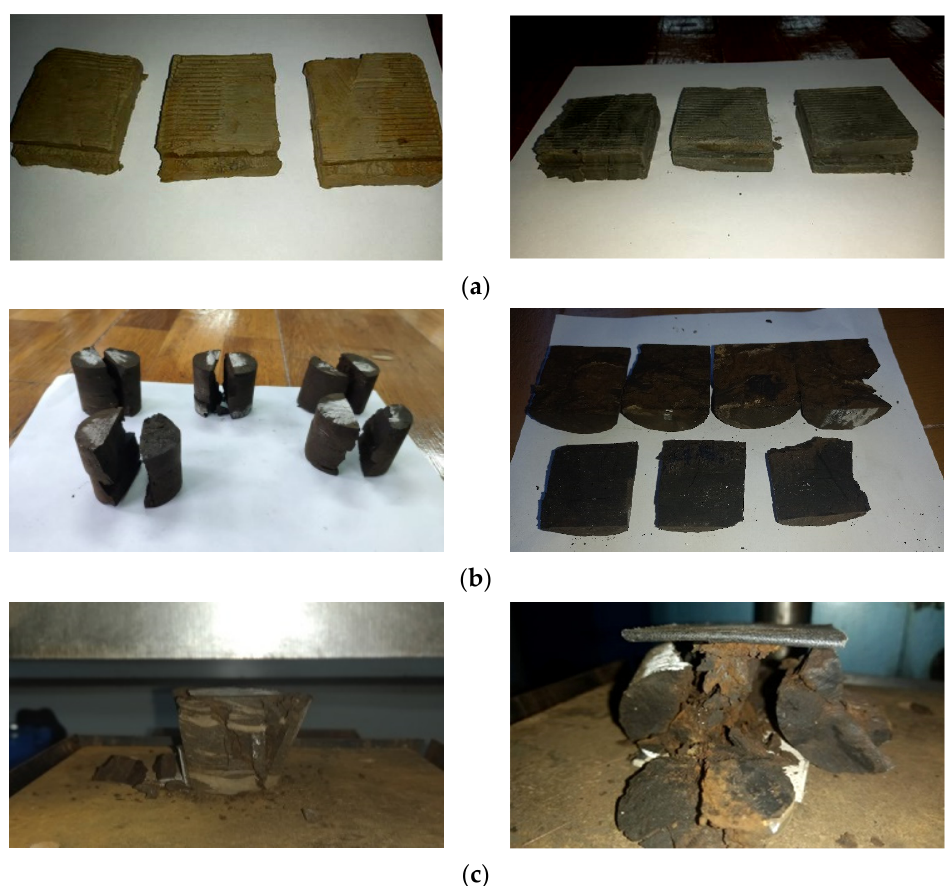
Figure 5. Laboratory tests: ( a ) direct shearing tests on yellow-brown clay and sandy marl; ( b ) shearing tests on lignite (mandatory planes); ( c ) uniaxial compression and traction (Brazilian method) on lignite [65].